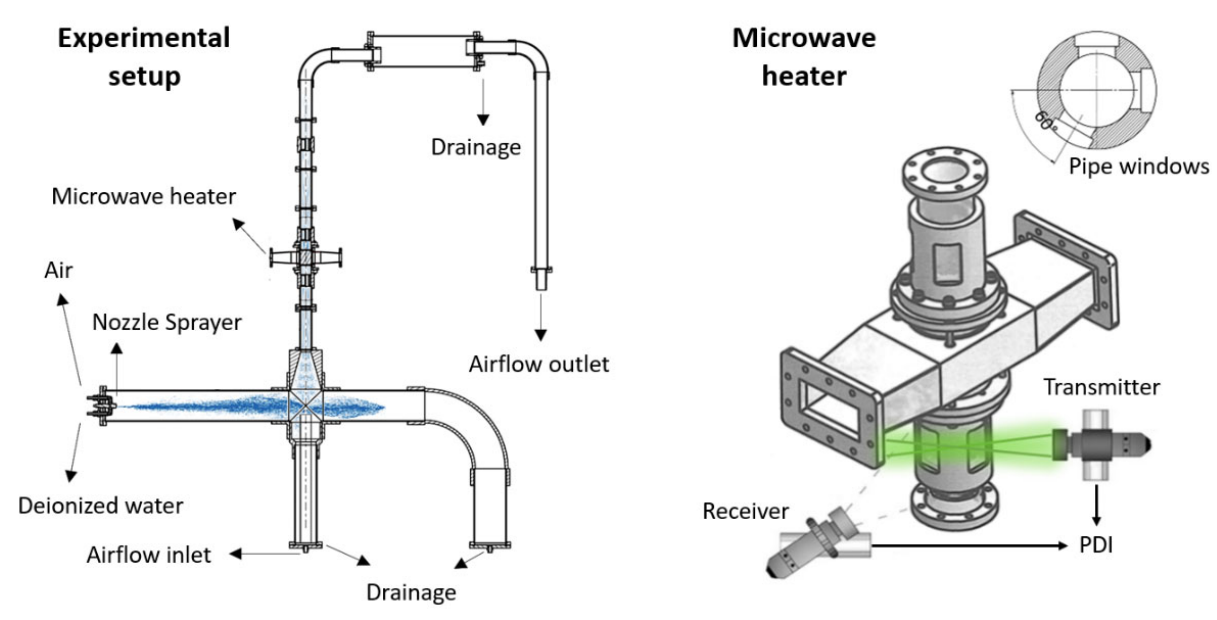
Figure 5. Experimental setup with details of microwave applicator and PDI measurement system.